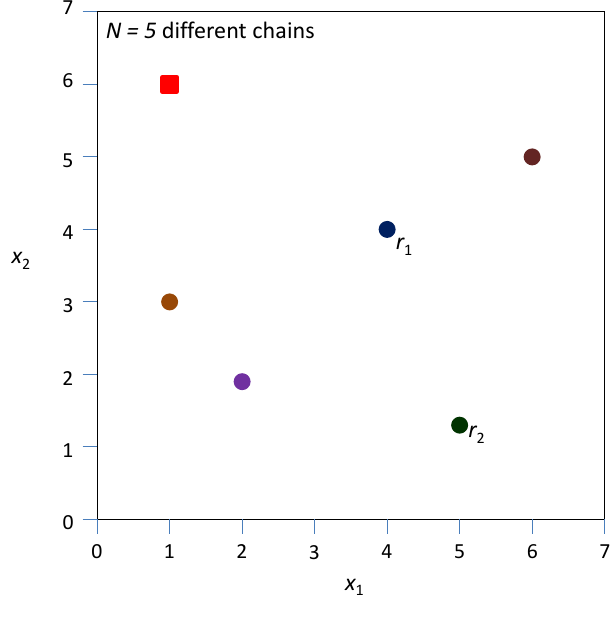
Fig. 2. Illustration of detailed balance: two-dimensional parameter estimation problem with x 1 ∈ [ 0 , 7 ] and x 2 ∈ [ 0 , 7 ] . The color dots denote the starting points of the N = 5 different chains. The red square signifies the candidate point of the first chain and is created by selecting the blue chain as r 1 and green chain as r 2 . One step later, after moving to the red square, the backward jump has equal probability, as there is an equal chance of drawing r 1 (green) and r 2 (blue) in reversed